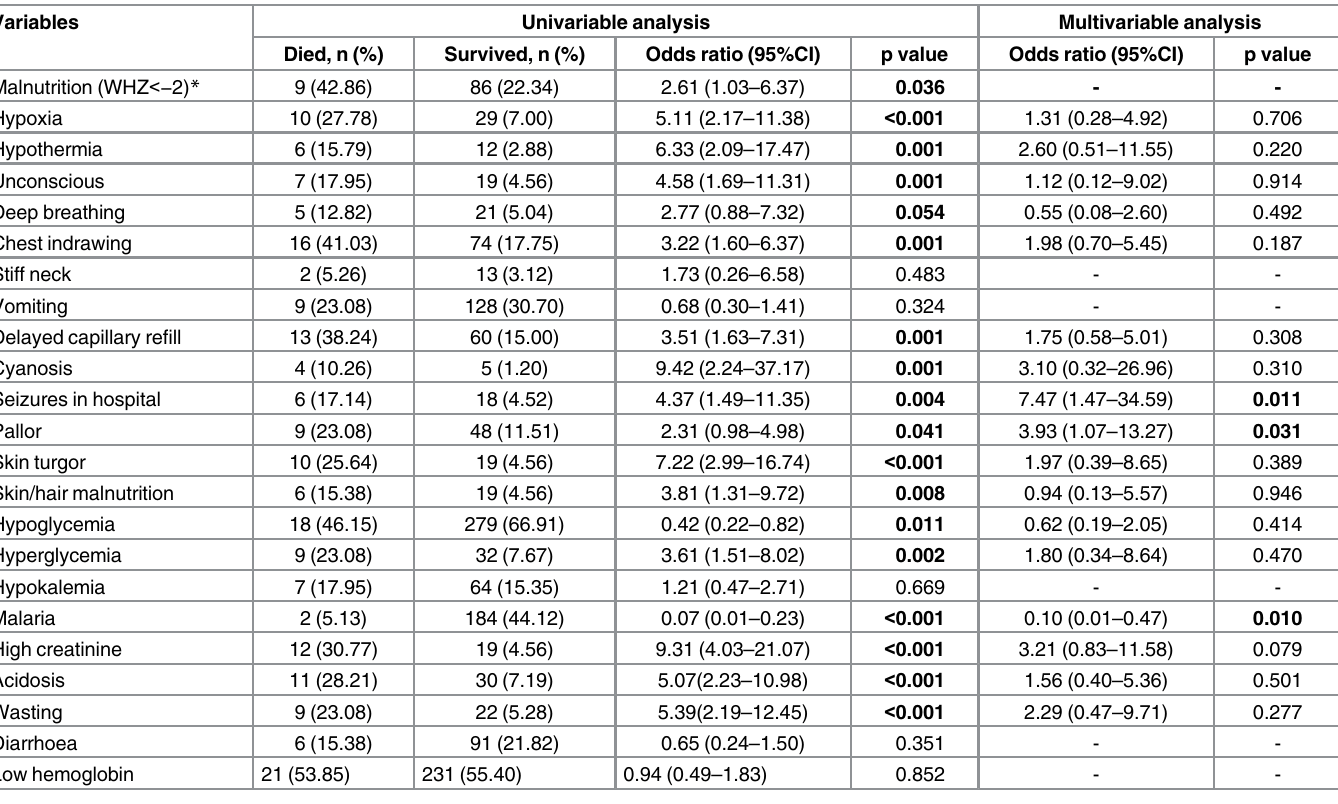
Table 4. Factors associated with death in